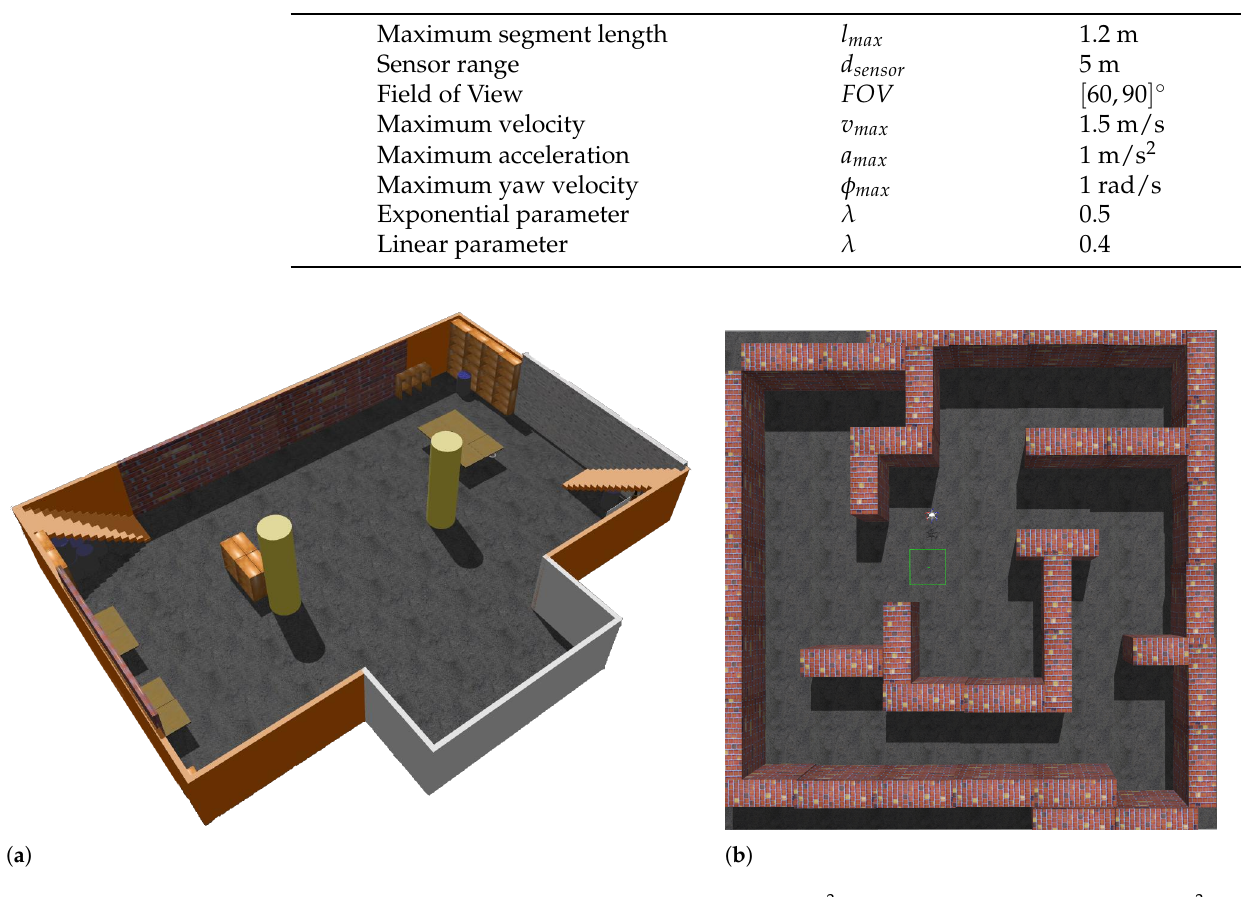
Figure 5. Two scenarios in Gazebo, ( a ) 20 × 12 × 3 m 3 indoor scenario. ( b ) 15 × 15 × 2 m 3 maze scenario, the green box depicts the initial position of the